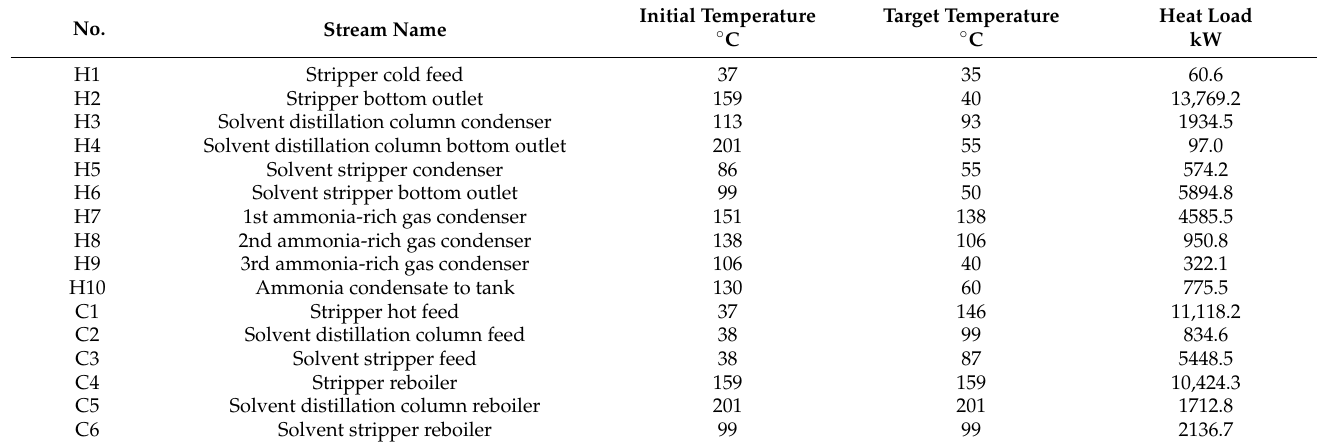
Table 4. Information on the heat exchanger obtained from the